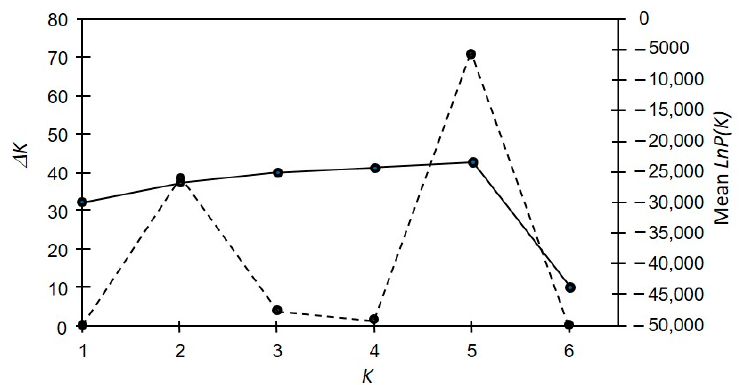
Figure 2. Bayesian clustering of 37 F. nilgerrensis plants. The average log probability value Ln P ( K ) (solid line) and modal value of ∆ K (dashed line) or distinctive genetic groups K are shown. The ∆ K values are based on 20 replicates for each value of K using the ADMIXTURE